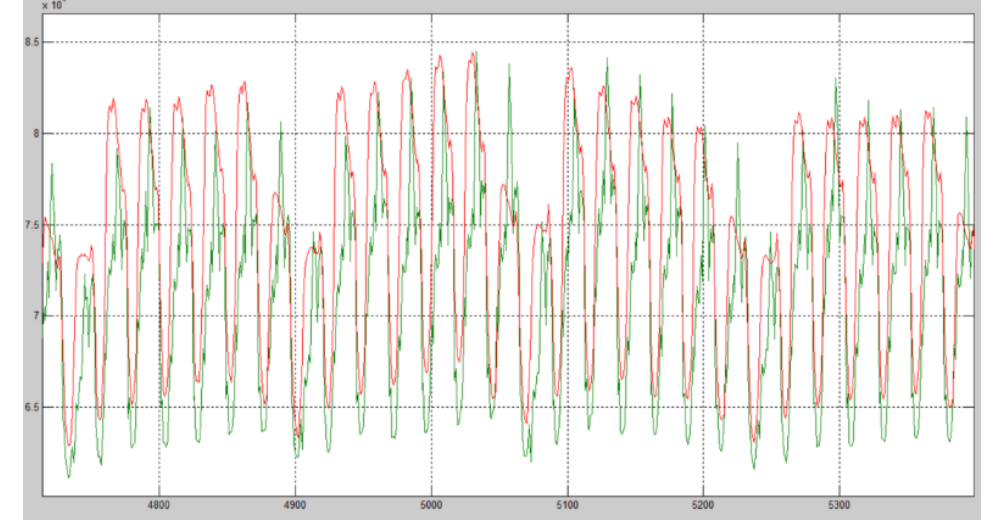
Figure 7. Forecasting results.